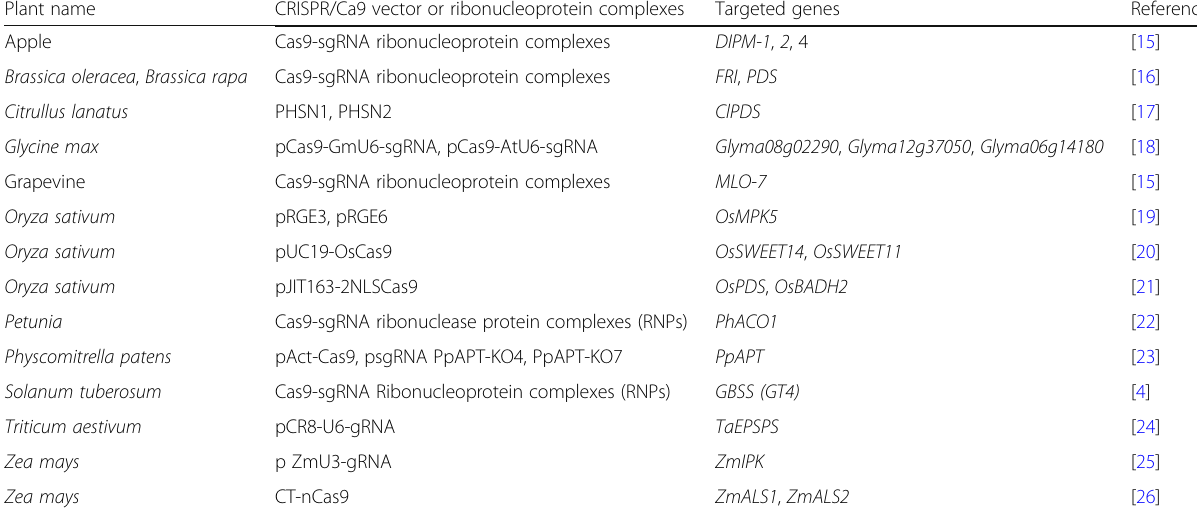
Table 1 PEG mediated CRISPR/Cas9 components delivery into different plants Plant name